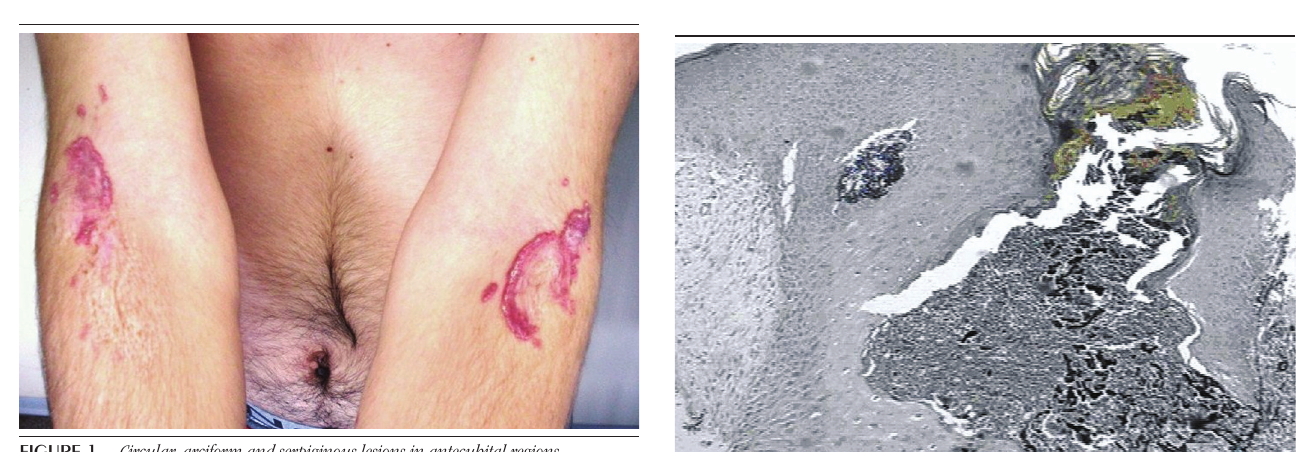
FigurE 3 − Foreign body-type multinucleated giant cell engulfing the fragments of degenerated elastic fibers (HE, 1,000×) HE: hematoxylin and eosin.